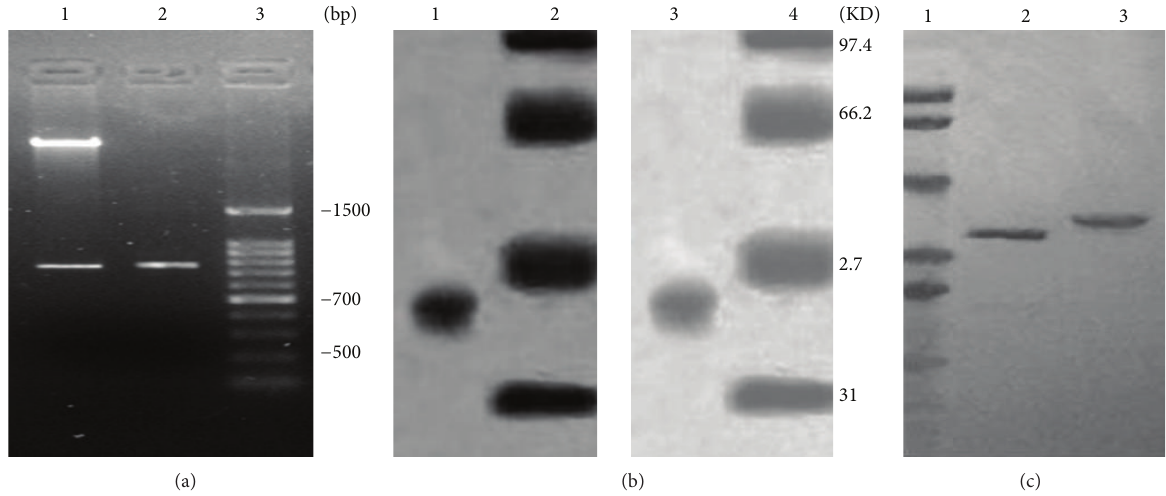
Figure 1: Characterization of fused gene and fusion protein of (RGD) 3 -TF . (a) PCR products of (RGD) 3 -tTF-pET22b(+); 1: PCR products of (RGD) 3 -tTF-pET22b(+) digested by restriction enzyme; 2: PCR products of gene of (RGD) 3 -tTF; 3: DNA marker. (b) Purification of (RGD) 3 - tTF. 1 and 2: SDS-PAGE; 3 and 4: Western blot; 1 and 3: (RGD) 3 -tTF; 2 and 4: prestained molecular weight standards. (c) Identification of purified (RGD) 3 -tTf. 1: molecular weight markers; 2: (RGD) 3 -tTF detected using the anti-TF antibody; 3: purified (RGD) 3 -tTF detected using the anti-RGD